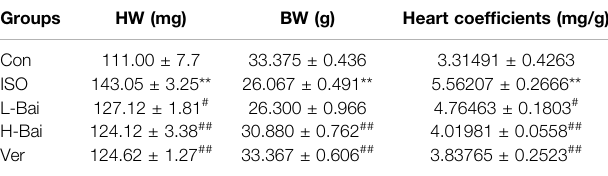
TABLE 2 | Effects of Bai on heart coef fi cients in